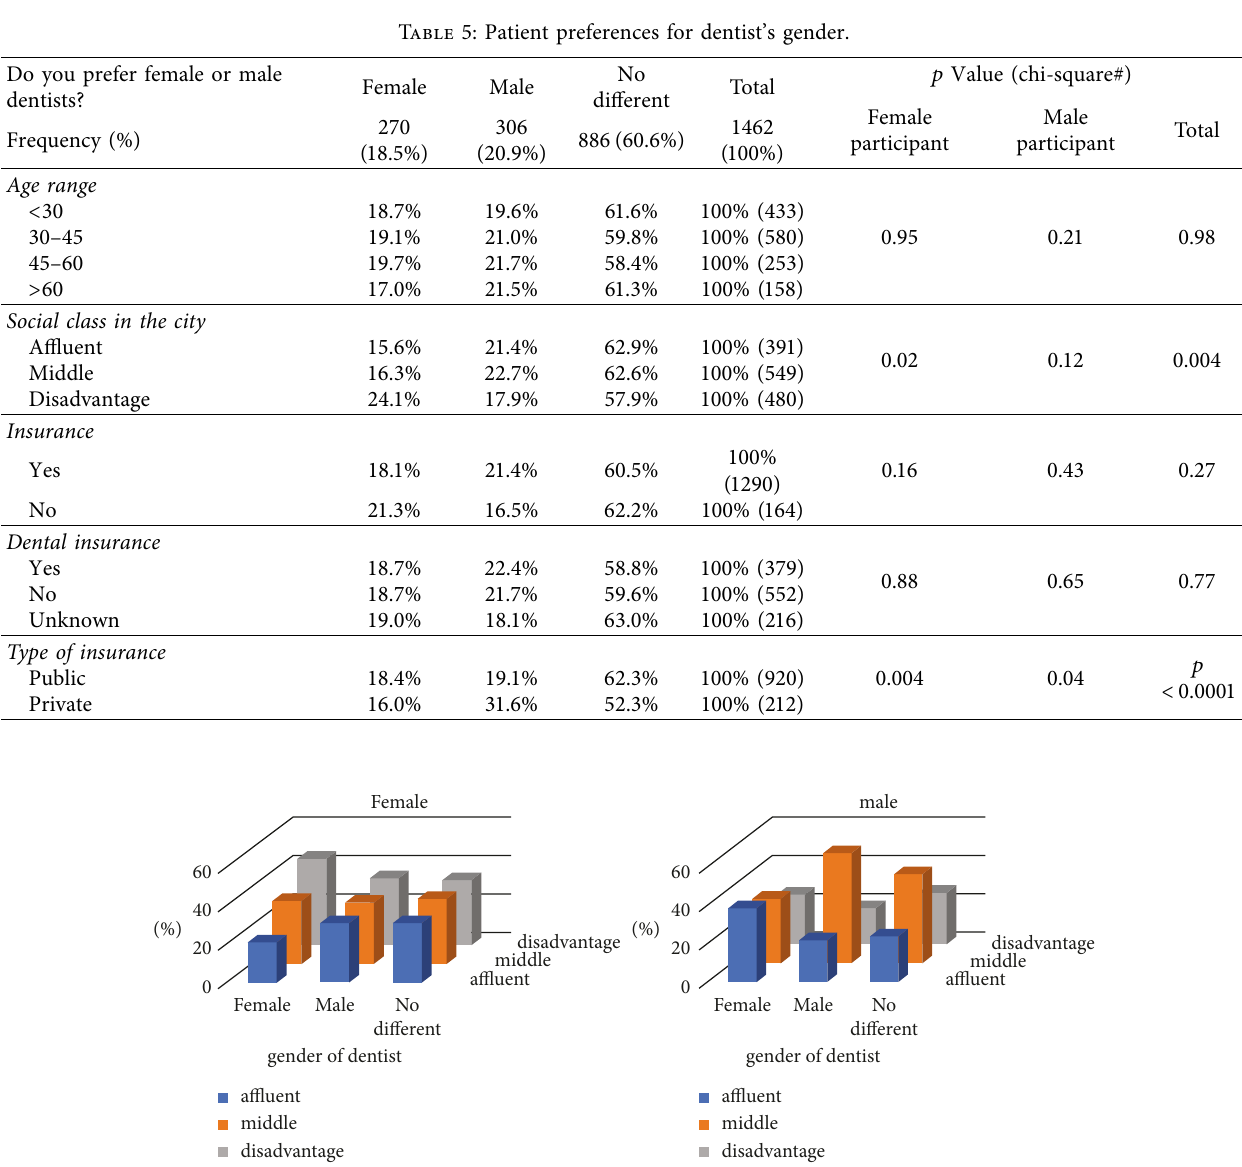
Figure 1: The difference in preferences by the participant’s gender concerning their social